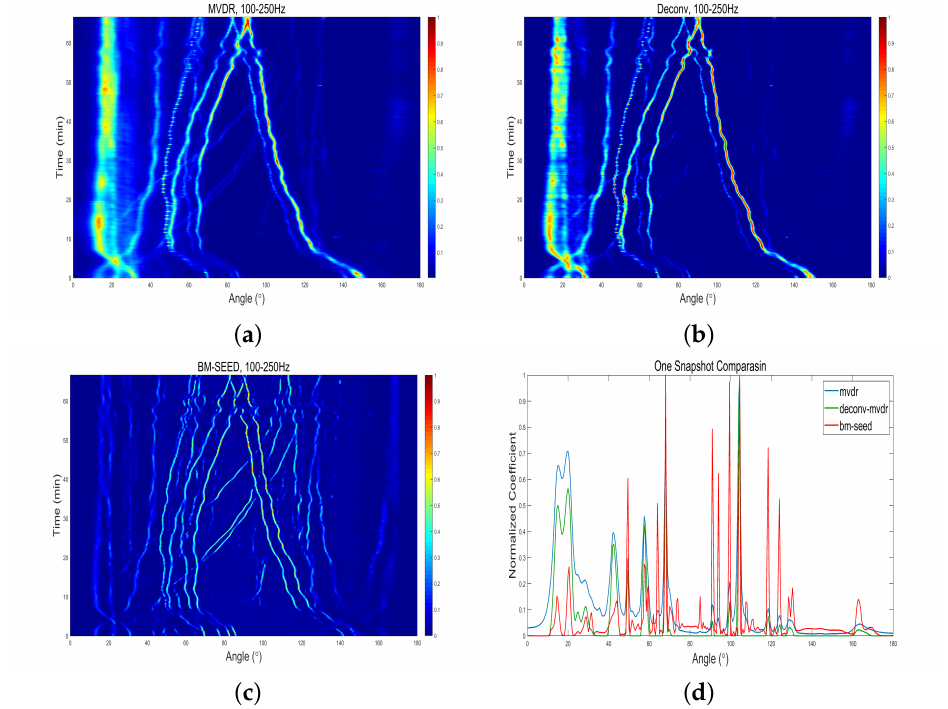
Figure 12. Sea-trial experiments 2. ( a ) Original MVDR2; ( b ) Deconv MVDR2; ( c ) BM-SEED MVDR2; ( b ) Snapshot